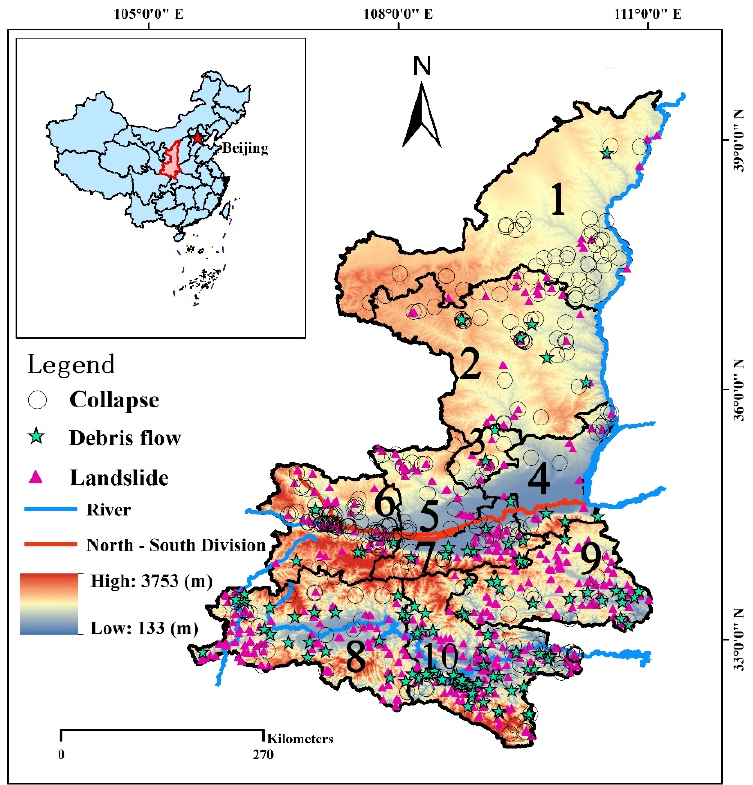
Figure 1. Study area and locations of geological hazards (0–10 represent the big cities and their suburbs and their names and abbreviations are listed as follows: 1 Yulin (YL) 2 Yanan (YA) 3 Tongchuan (TC) 4 Weinan (WN) 5 Xianyang (XY) 6 Baoji (BJ) 7 Xian (XA) 8 Hanzhong (HZ) 9 Shangluo (SL) 10 Ankang (AK)) .